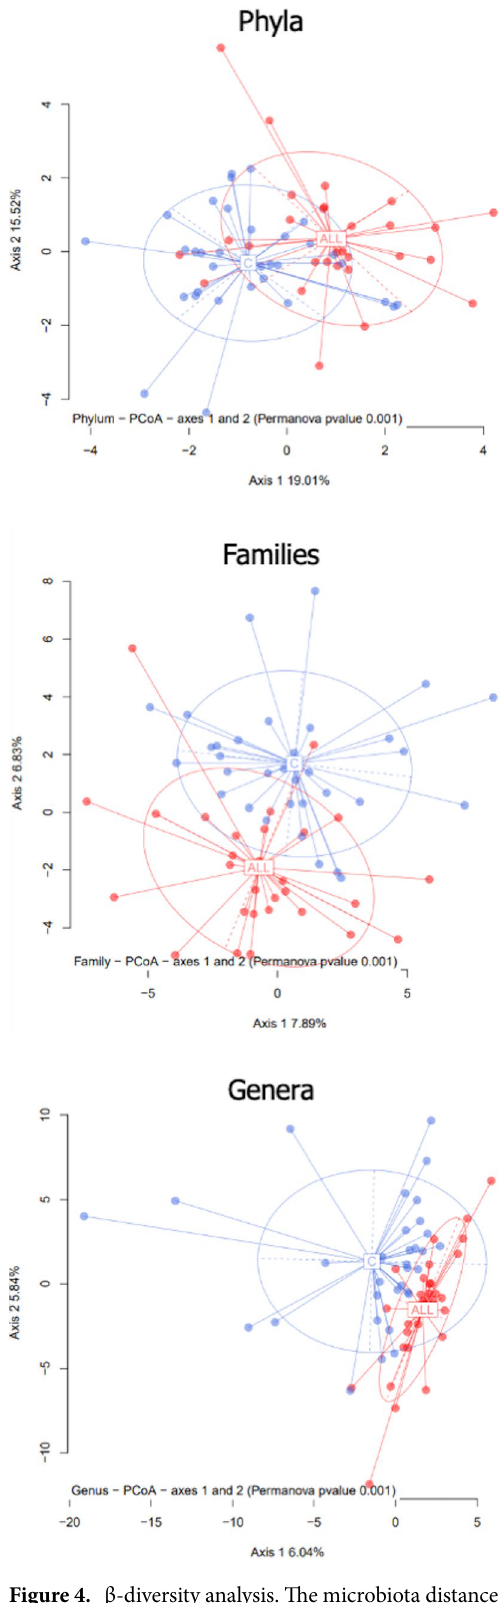
Figure 4. β-diversity analysis. The microbiota distances were visualized through Principal Coordinates Analysis (PcoA). The figure shows the taxonomic levels of phyla, families, and genera. The significance threshold (p-value) for the PERMANOVA was set <